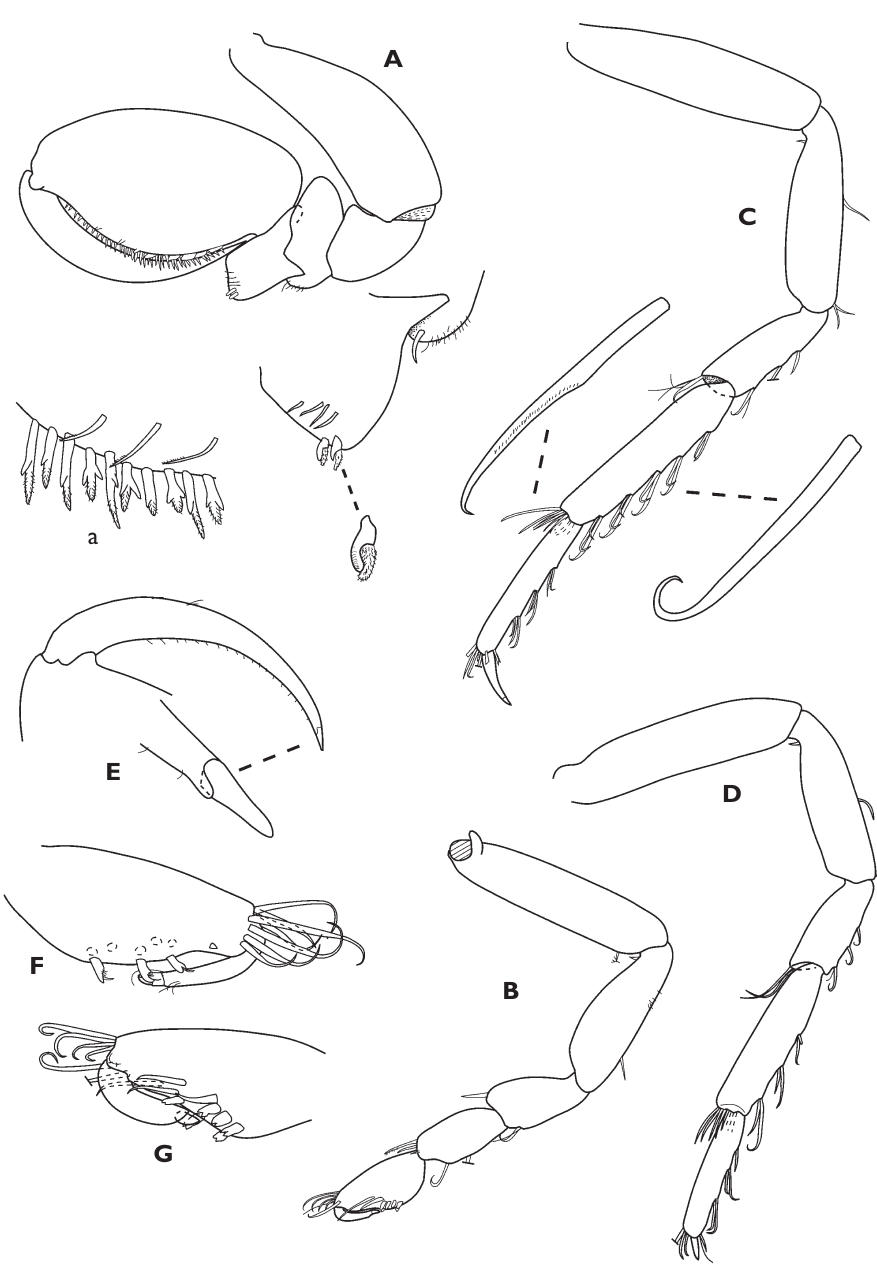
Figure 7. Sedorolis simplex sp. n. Paratype ♂ 4.8 mm, Is.6001, except E, F ♀ unmeasured, Is. 6004. A–D pereopods 1, 2, 6 and 7 respectively a detail of pereopod 1 propodal palm setae E pereopod 1 dactylus F pereopod 2 propodus, mesial G pereopod propodus,